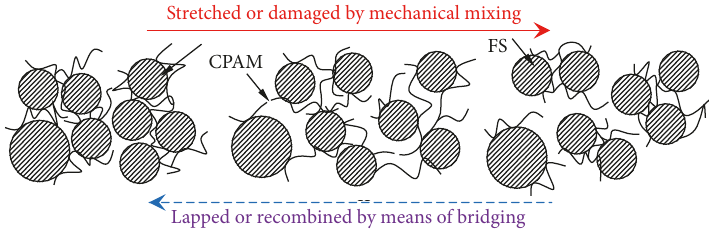
Figure 3: The dynamic damage and recovery process of